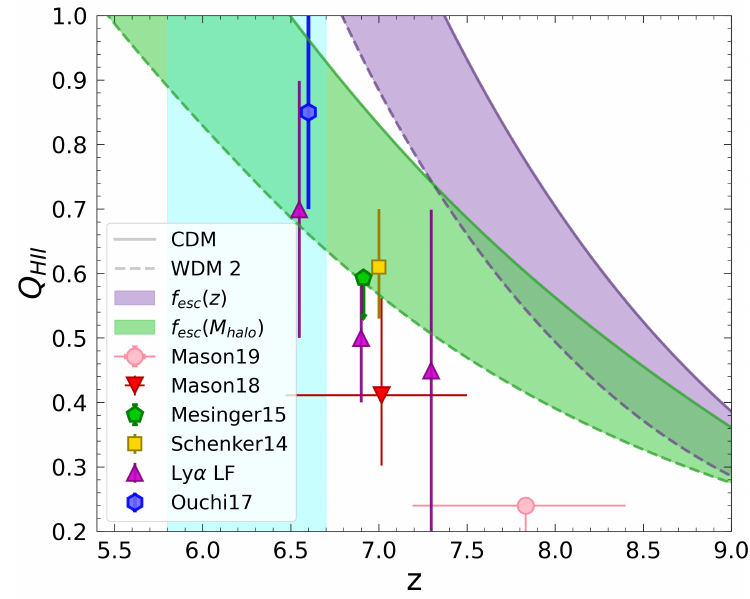
Figure 8. Evolution of the filling fraction Q HII , for CDM and WDM 2 models, with f esc ( M halo ) as computed by Yajima et al. (2011) [57] and f esc ( z ) by Puchwein et al. (2019) [58], with log ( ξ ion / ( erg − 1 Hz )) = 24.9. The cyan shaded region indicates our fiducial late-Reionization redshift interval, 5.8 < z < 6.7. The upward triangle labelled Ly α LF includes results by Konno et al. (2014), Konno et al. (2017) and Zheng et al. (2017)